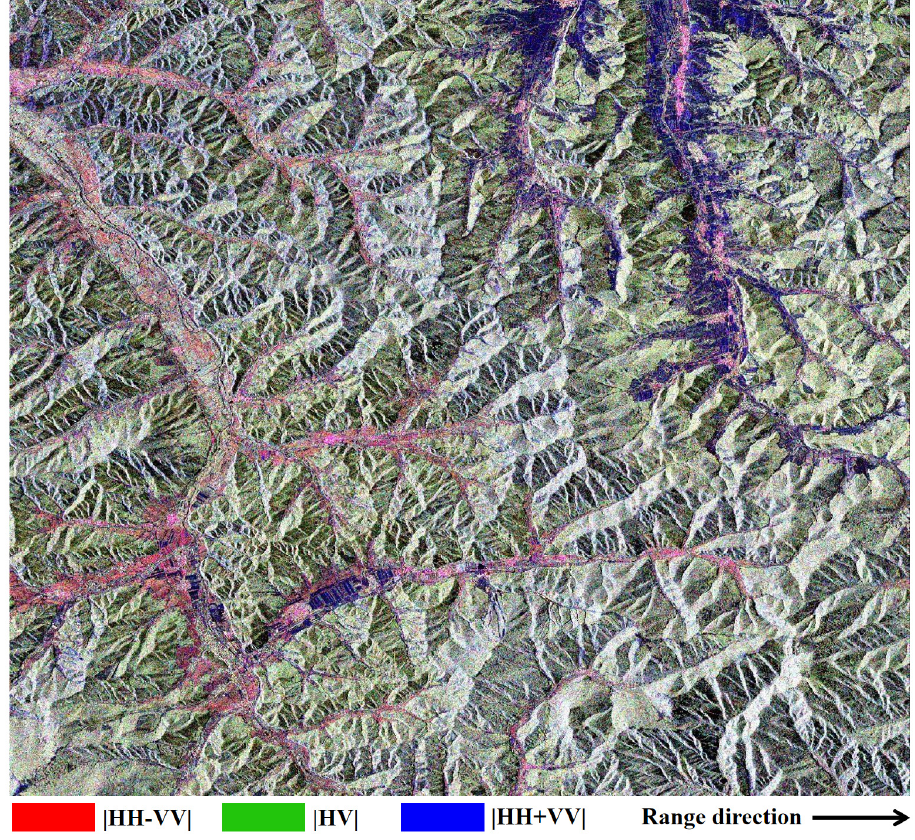
Figure 2. The Pauli RGB of PolSAR data over the test site.